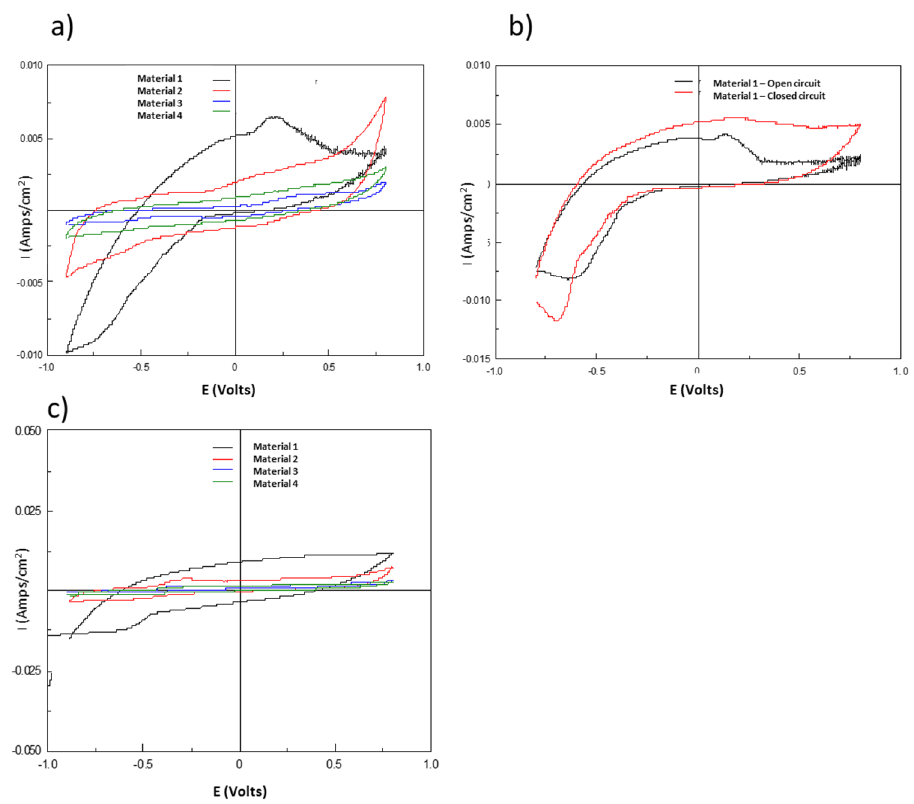
Figure 5. Cyclic voltammogram sweeps of materials 1, 2, 3 and 4: ( a ) closed-circuit and ( b ) cyclic voltammogram sweeps of material 1 (felt) open and closed circuits using a 0.5 mV / s scan rate. E (V) versus Ag / AgCl and ( c ) open circuit using 1 mV / s scan rates for material 1 and 25 mV / s scan rates for materials 2, 3 and 4. E (V) versus Ag/AgCl. Table 3. First derivative potentials and amplitudes for closed- and open-circuit oxidative and reductive sweeps. E (V) versus Ag/AgCl.